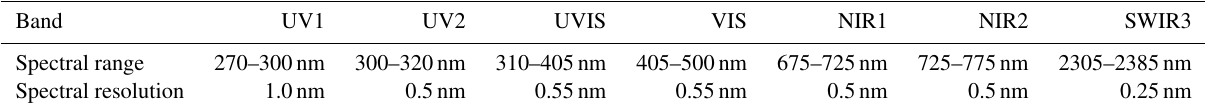
Table 1. Characteristics of S5P/TROPOMI spectral bands. “UVIS” indicates the combination of longwave ultraviolet and visible bands. Band UV1 UV2 UVIS VIS NIR1 NIR2 SWIR3 Spectral range